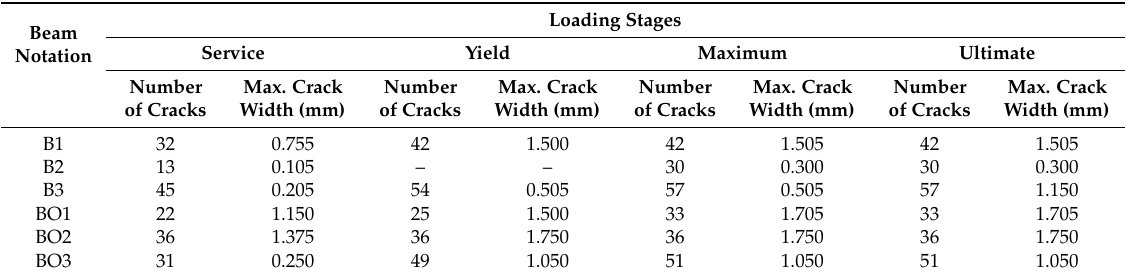
Table 8. Number of cracks and maximum crack width at service, yield, maximum and ultimate loading